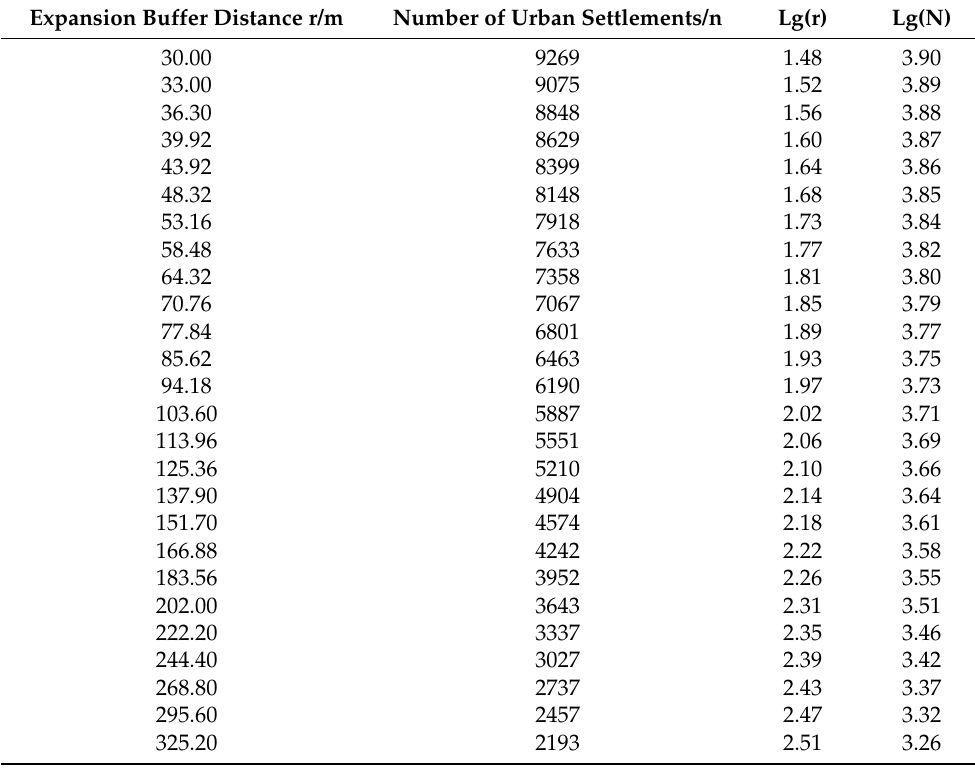
Table 1. Urban expansion of